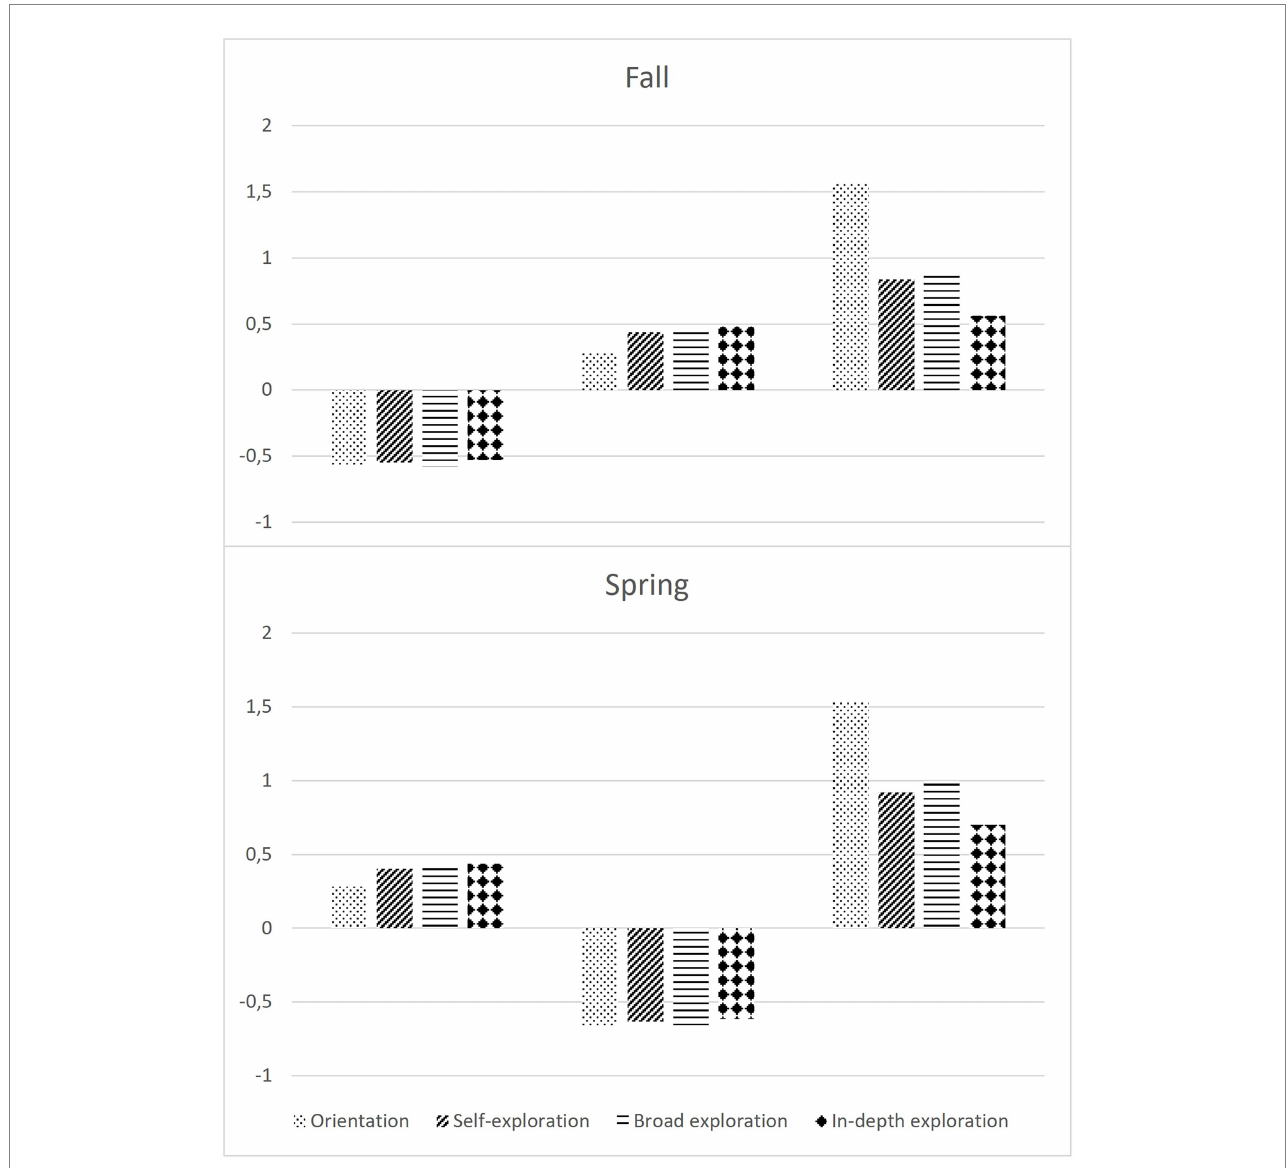
FIGURE 2 The three exploration profiles and corresponding z-scores for the four decisional tasks at both timepoints.